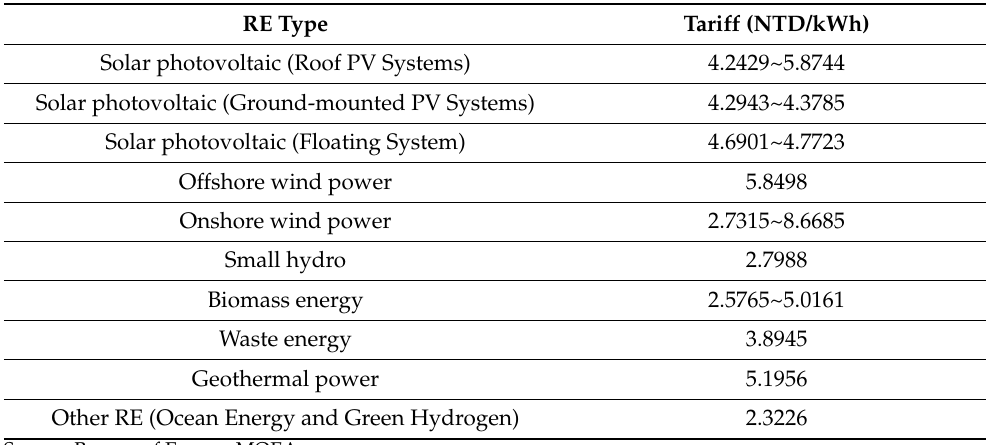
Table 10. RE feed-in tariffs in Taiwan by